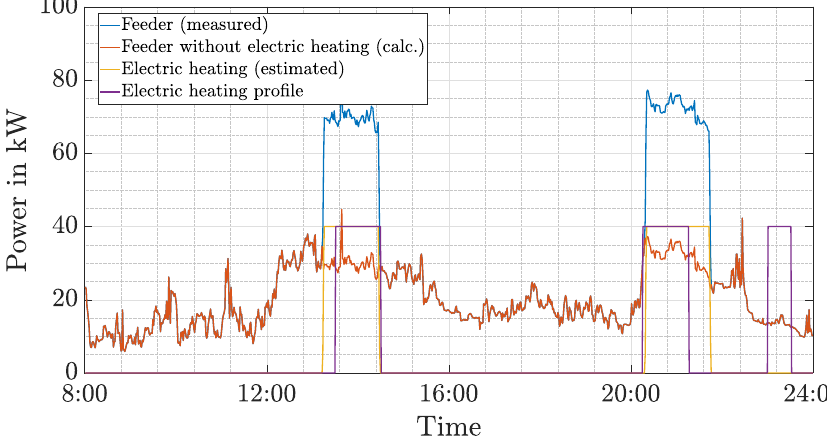
Figure 5. Profiles for the energy consumption of the households and electric heating as well as EV charging.